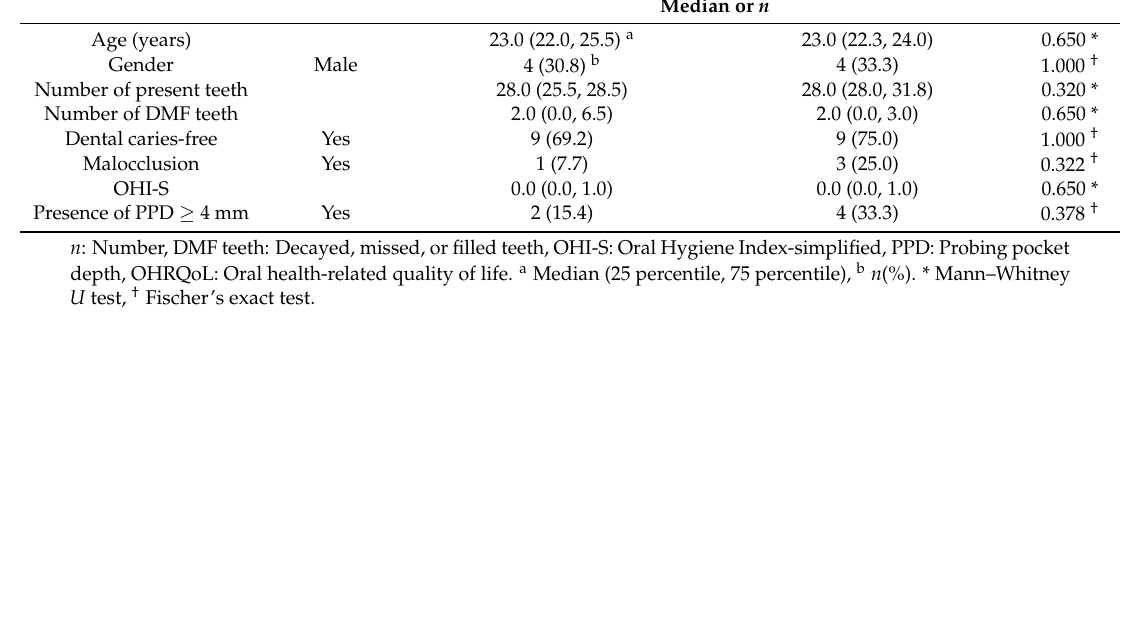
Table 1. Characteristics of high-OHRQoL group and low-OHRQoL group.